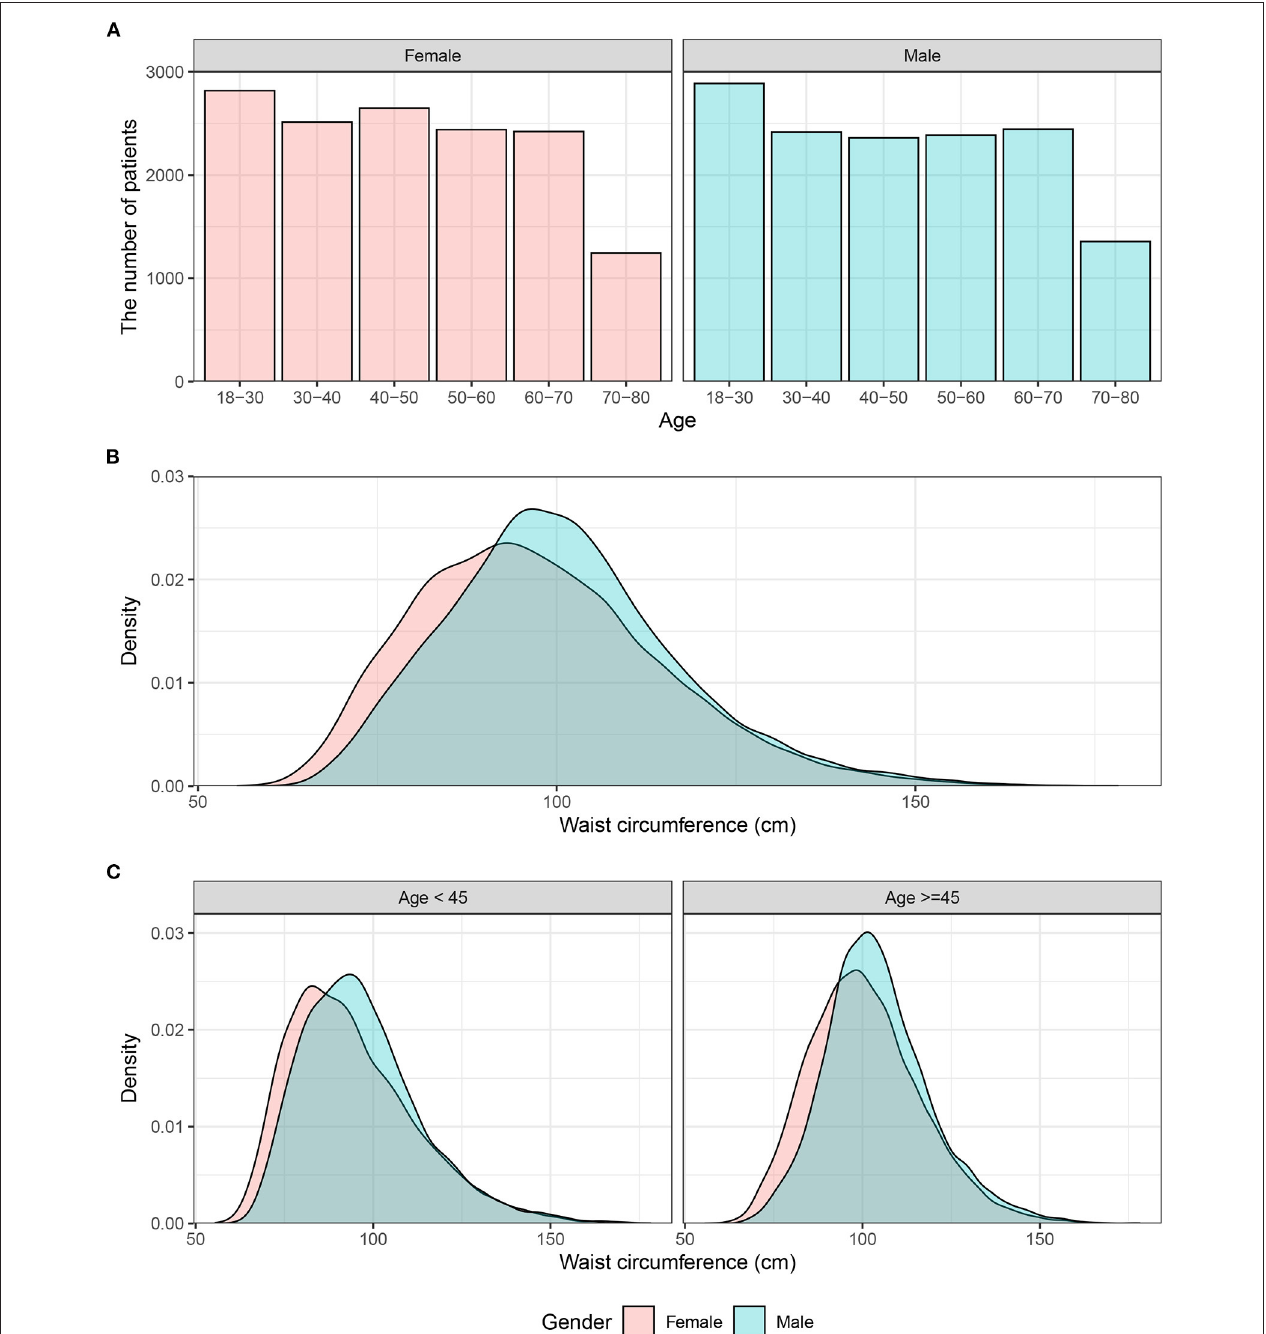
FIGURE 1 | Distribution of waist circumference in males and females. (A) Histograms of age distribution in male and female individuals. (B) The overall distribution of waist circumference. (C) The distribution of waist circumference in individuals < 45 years or ≥ 45 years old.